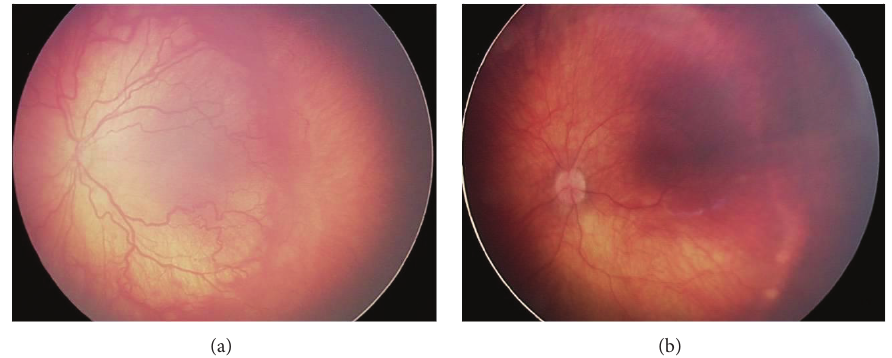
Figure 2: (a) Zone I disease prior to the bevacizumab injection: female infant, BW 2050 g, GA 28 w, treated with intravitreal bevacizumab at PMA of 34 weeks and PNA of 6 weeks. (b) The same case as in (a), 8 weeks after the intravitreal injection of bevacizumab showing ROP